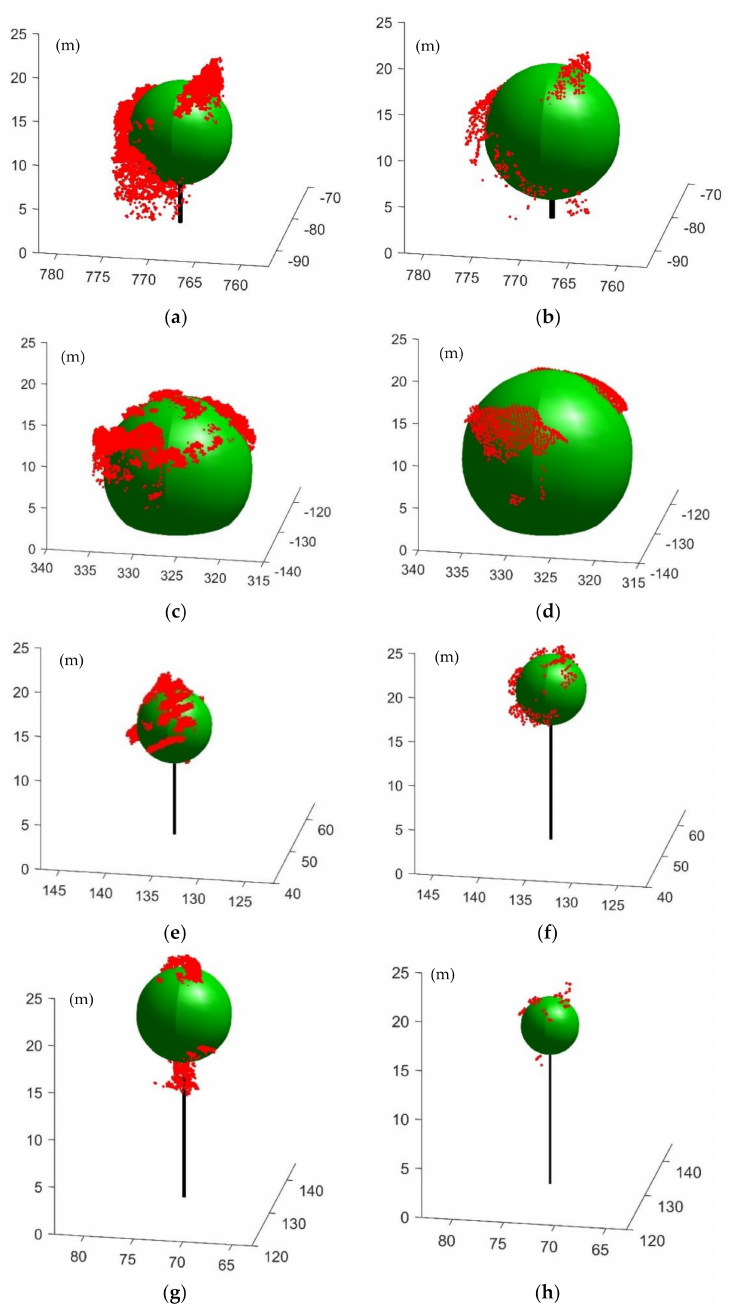
Figure 9. 3D model by sphere fitting method of ( a ) the first tree sample using the LiDAR method, ( b ) the first tree sample using the photogrammetric method, ( c ) the second tree sample using the LiDAR method, ( d ) the second tree sample using the photogrammetric method, ( e ) the third tree sample using the LiDAR method, ( f ) the third tree sample using the photogrammetric method, ( g ) the fourth tree sample using the LiDAR method, and ( h ) the fourth tree sample using the photogrammetric